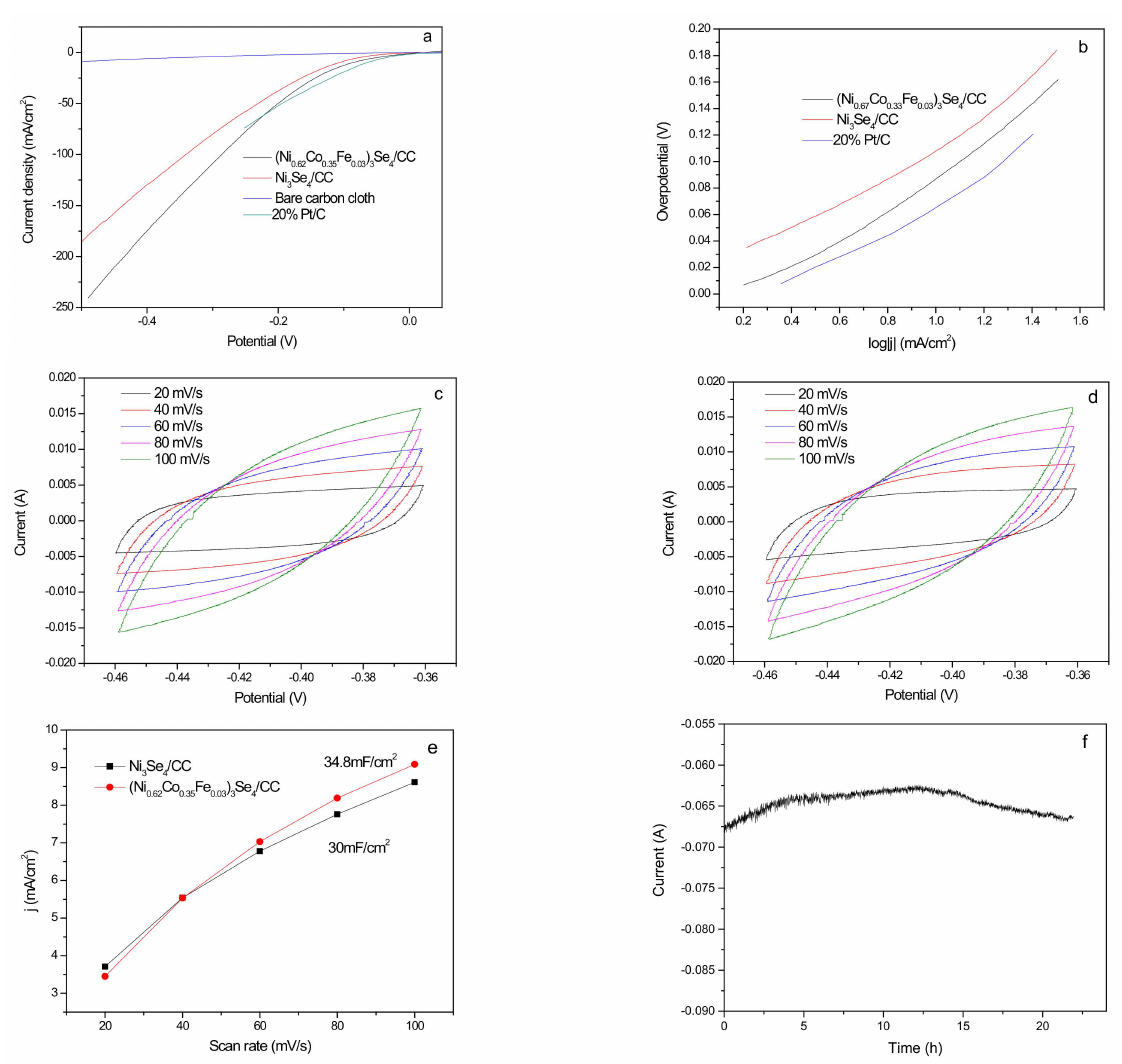
Figure 5. ( a ) HER LSV curves of (Ni 0.62 Co 0.35 Fe 0.03 ) 3 Se 4 /CC, Ni 3 Se 4 /CC; ( b ) correspond- ing Tafel plots; ( c , d ) CV curves at different scanning speeds; ( e ) The estimated C dl of (Ni 0.62 Co 0.35 Fe 0.03 ) 3 Se 4 /CC, Ni 3 Se 4 /CC; ( f ) Chronopotentiometry of (Ni 0.62 Co 0.35 Fe 0.03 ) 3 Se 4 /CC (1.5 V relative to hydrogen electrode). All tests were performed in 1 M KOH